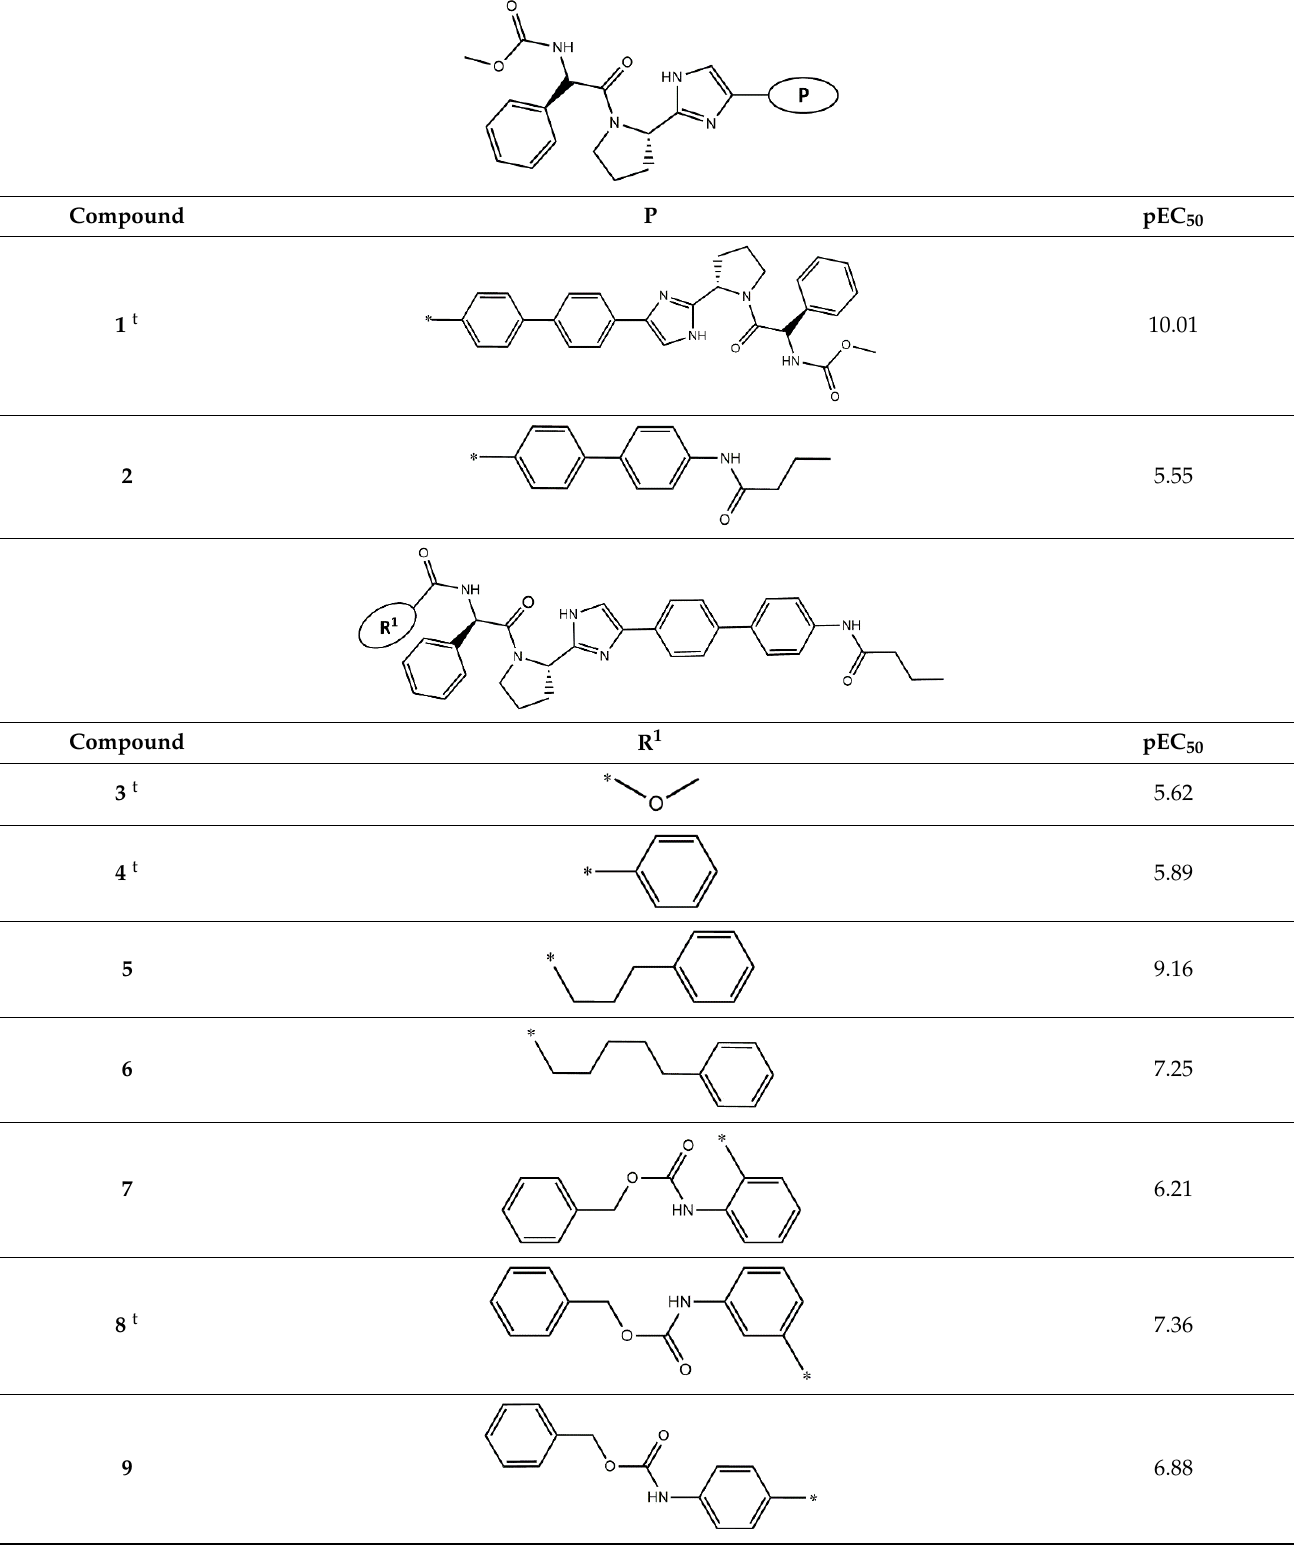
Table 5. Chemical structures and the studied biological activity data.